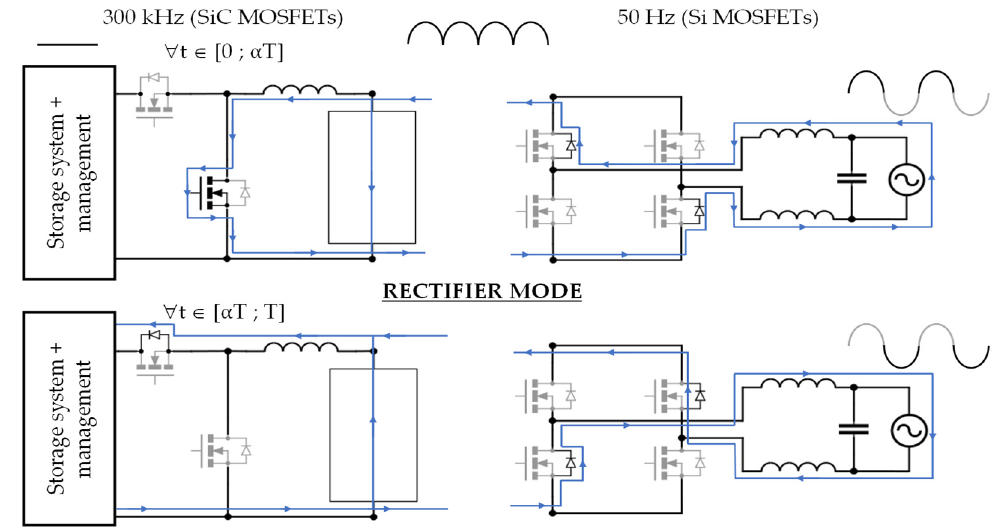
Figure 4. Schematic diagram of the converter in PFC rectifier mode.